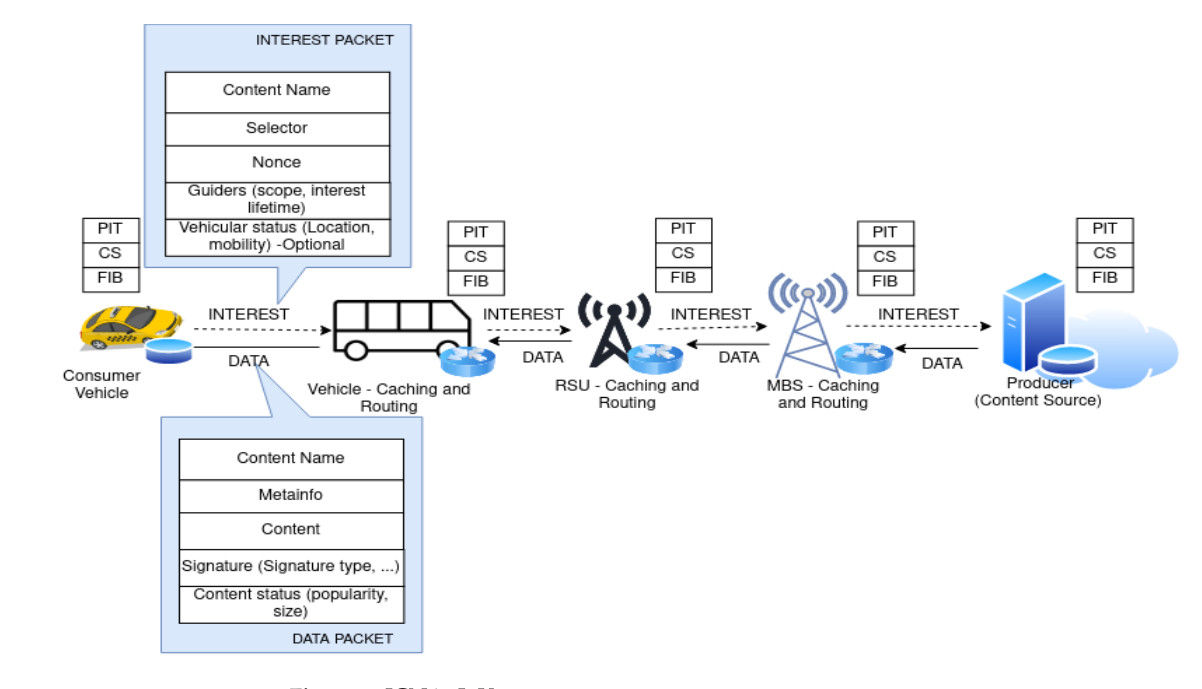
Figure 1. ICN in